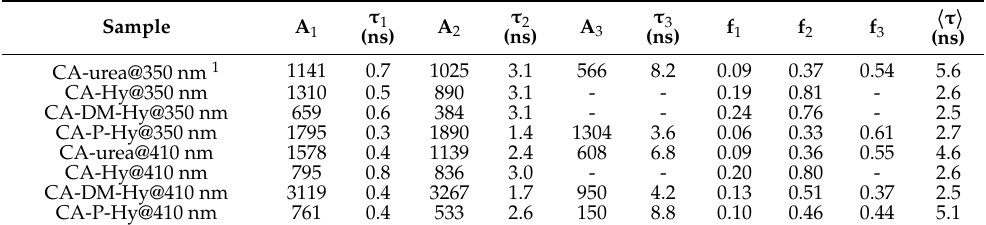
Table 1. Fitting results of decay time data excited at 350 and 410 nm in the 50 ns window. A i is the pre-exponential factor, τ i is the lifetime, f i is the fractional contribution and 〈 τ 〉 is the average lifetime (Equation (S1)).